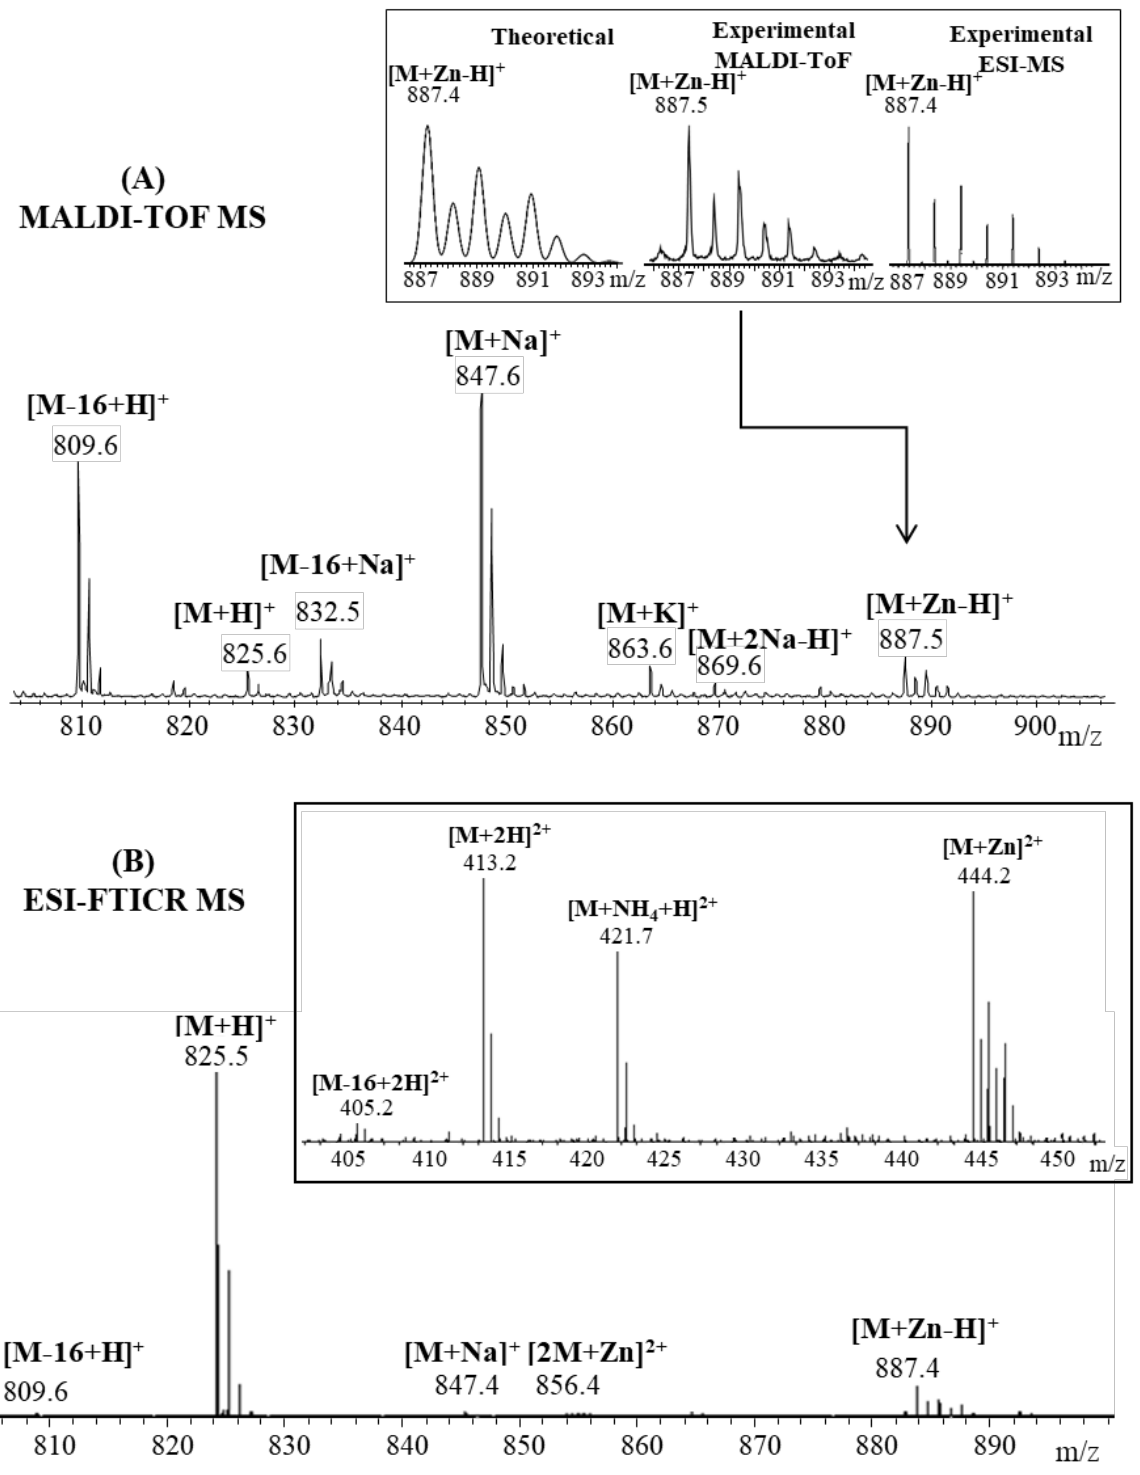
Figure 1. Enlarged region of mass spectra of NAP peptide incubated with Zn 2+ ions acquired by ( A ) MALDI ToF (reflectron mode) with CHCA matrix and ( B ) ESI-FTICR, both in positive mode. Inserts: ( A ) details of theoretical and experimental isotopic patterns of [M + Zn-H] + ion; ( B ) detail of the double-positive-charged peptide fragments.